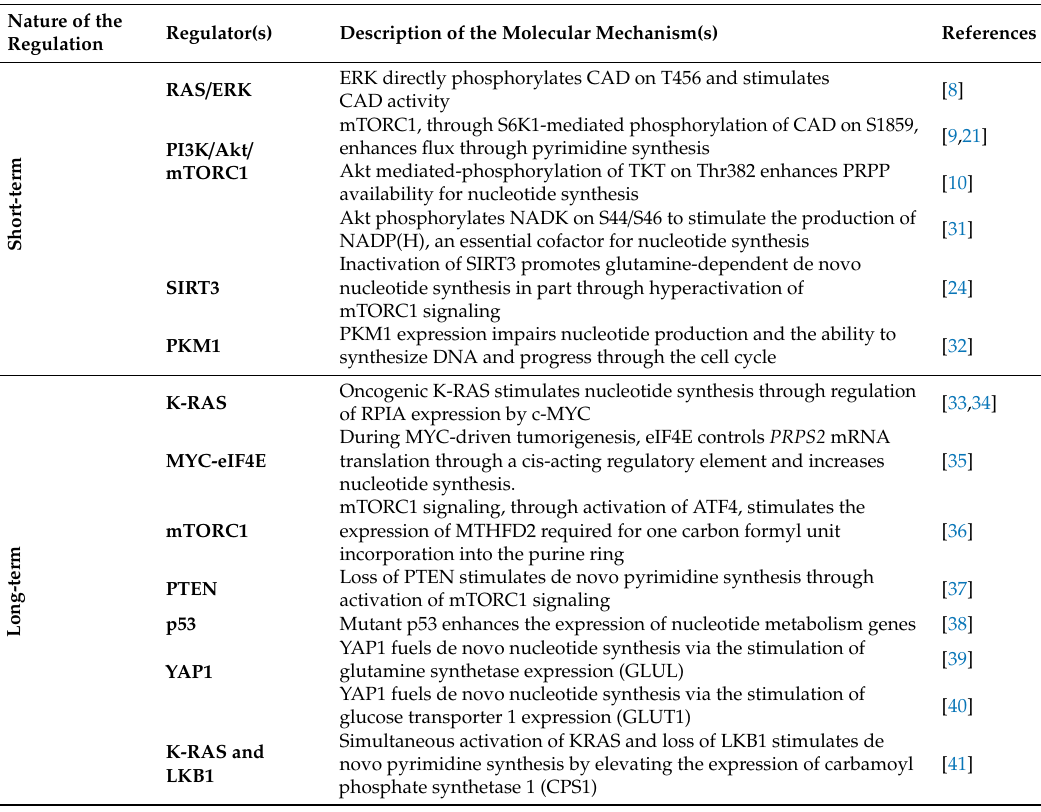
Table 1. Oncogenes and tumor suppressors involved in the short-term and long-term regulation of de novo nucleotide synthesis in tumor